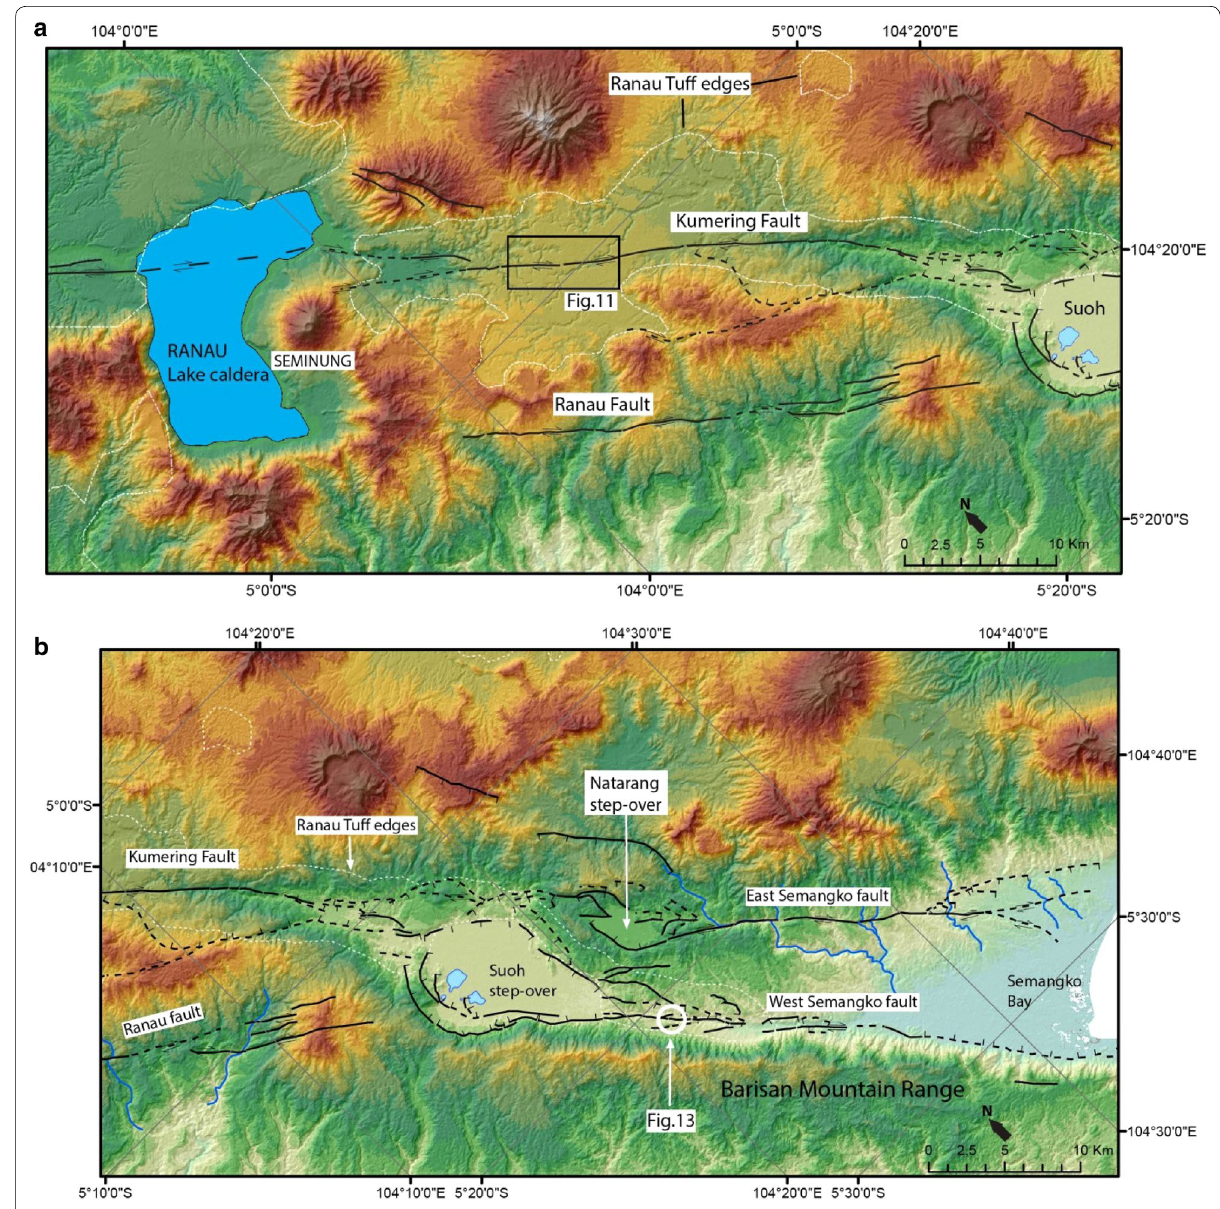
Fig. 3 Revised map of active faults in South Sumatra, showing the main fault traces and the areas where we have determined slip rates from offsets of channels cut through the Ranau Tuff. a Between Ranau Lake and Suoh. b Between Suoh and Semangko Bay. Digital elevation map is from